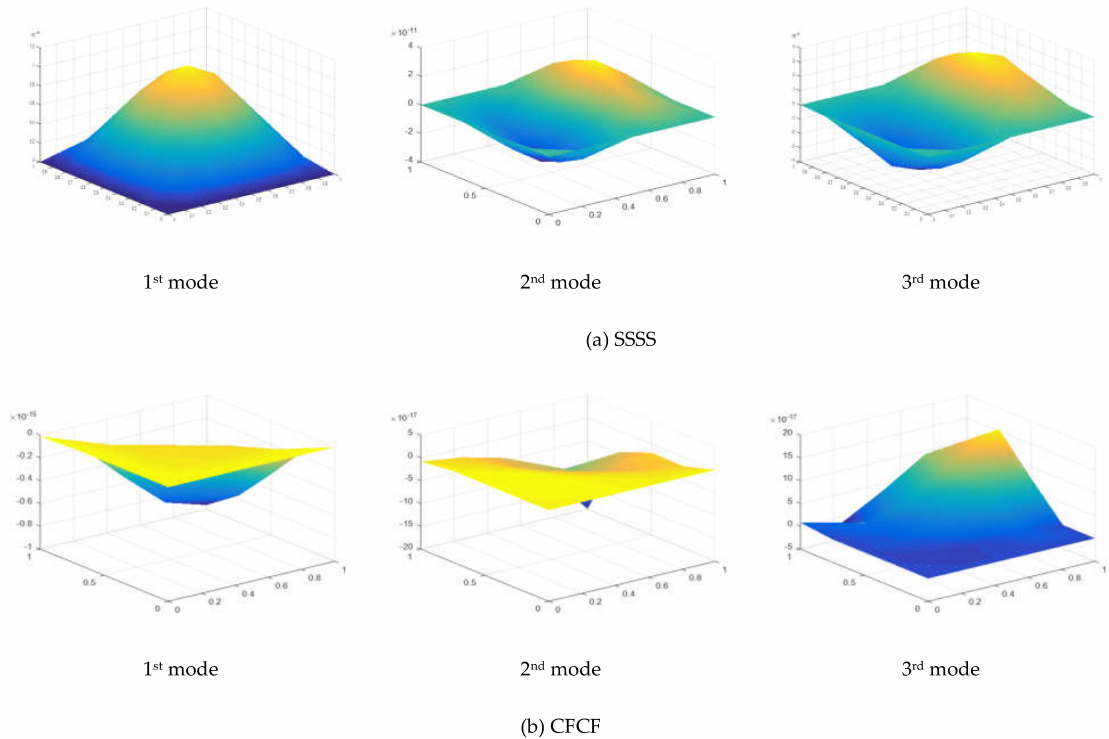
Figure 5. Mode shape for the square plate under biaxial compressive load.